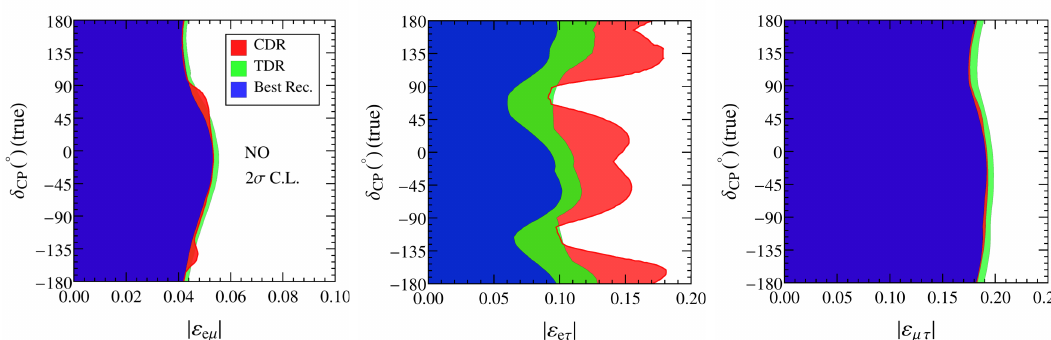
Figure 6 . Same as in figure 5 for the non-diagonal NSI parameters, but now assuming them to be